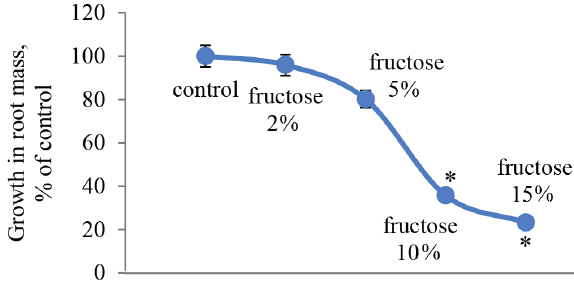
Figure 4 Growth in root mass after fructose treatment (n = 7). * P ≤ 0.1